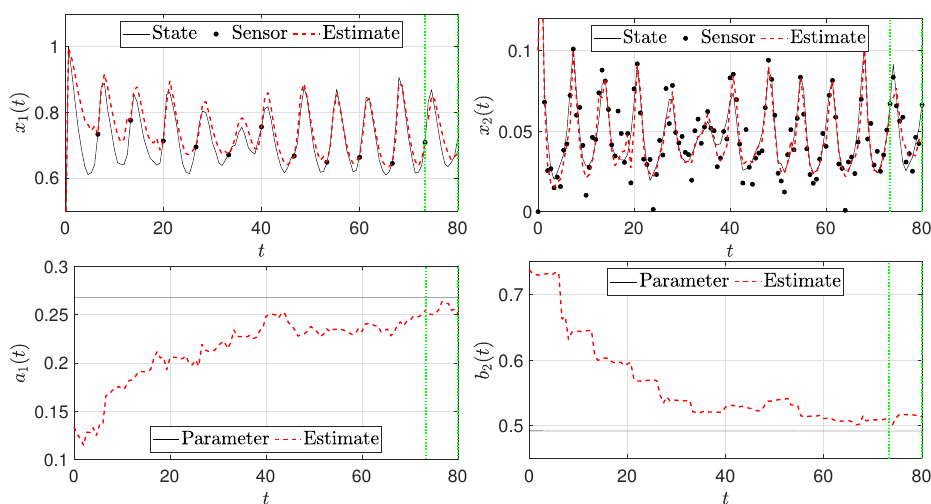
Figure 3. Simultaneous state and parameter estimation for nonlinear exothermic reactor: Results indicate that states and parameters can be reconstructed accurately. Yet, in particular for ˆ b 2 and early time points estimates improve significantly if slow sensor measurement is